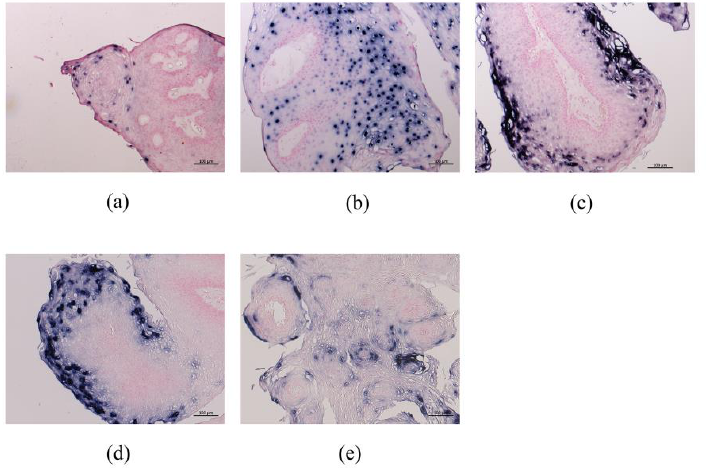
Figure 5. HPV mRNA expression in LP by RNA-ISH. Representative mRNA expression of ( a ) E6 ; ( b ) E2 ; ( c ) E4 ; ( d ) E5a ; ( e ) E5b . E4 and E5a were markedly expressed in the upper third of LP. Bar = 100 μm.